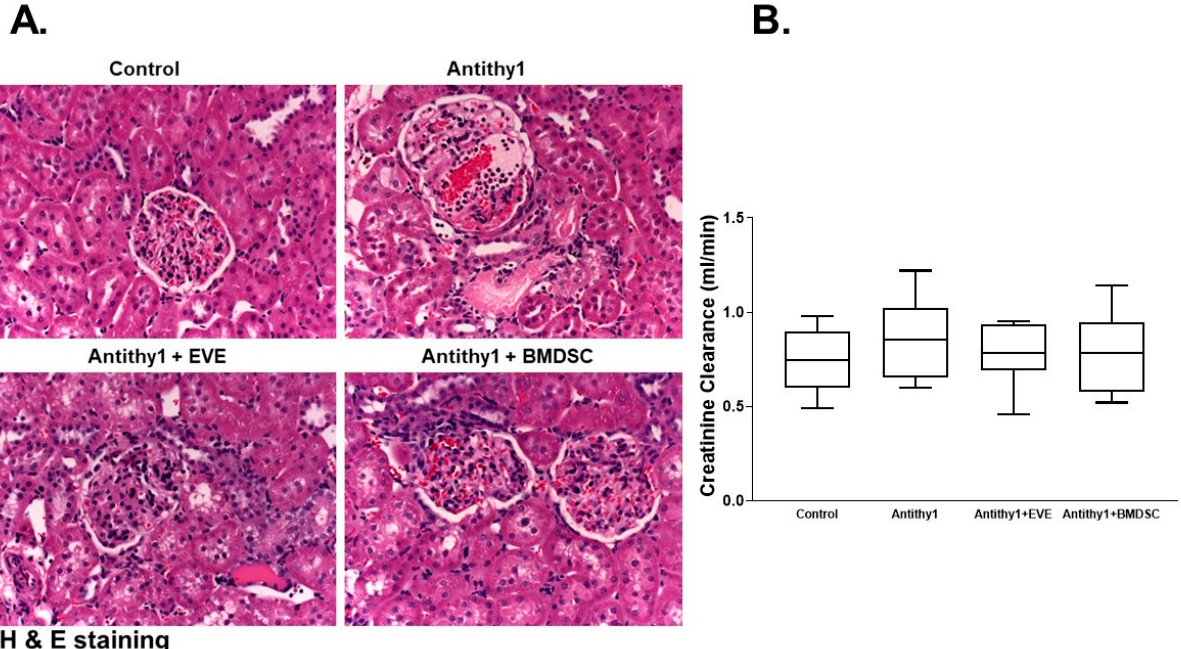
Figure 3. Representative H&E staining images for the kidney section ( A ) and creatinine clearance ( B ) from control and anti-Thy1-injected rats with or without everolimus or BMDSC treatment. Anti-Thy1-injected rats showed hypercellular glomeruli with loss of Bowman space and variable number of lymphocytes. Only everolimus treatment partially restored these pathophysiological changes (n = 4). There was no difference in creatinine clearance among rat groups (n = 6–8).